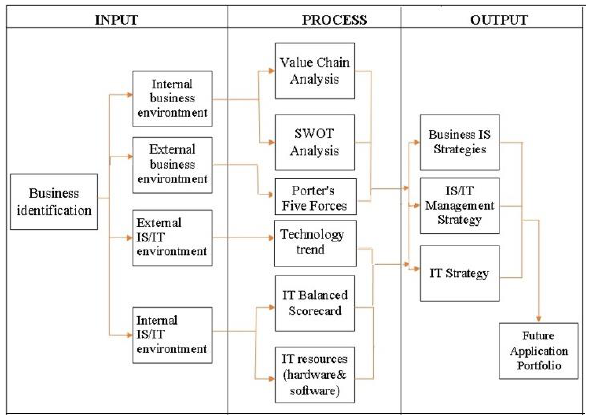
Figure 2: Methodology of Information System Strategic Planning for Pharmaceutical